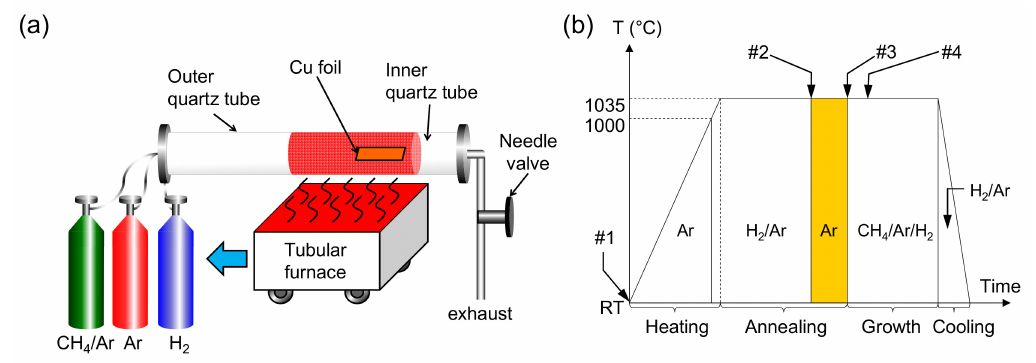
Figure 1. ( a ) A schematic illustration of the CVD setup; ( b ) A schematic illustration of a typical